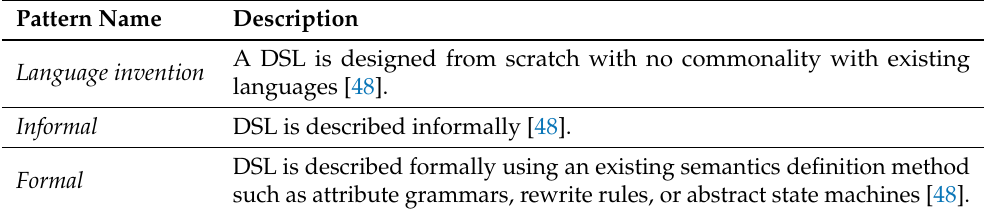
Table 7. Design patterns used during the design